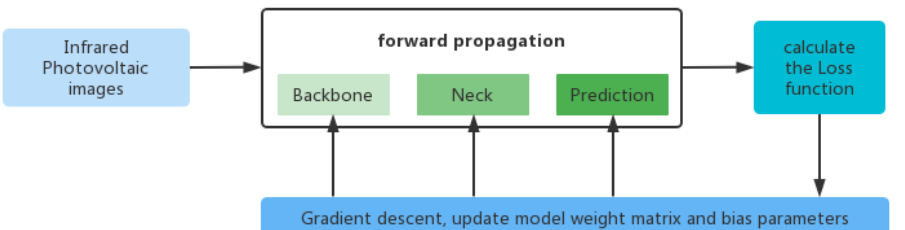
Figure 2. The training process of S-YOLOv5.